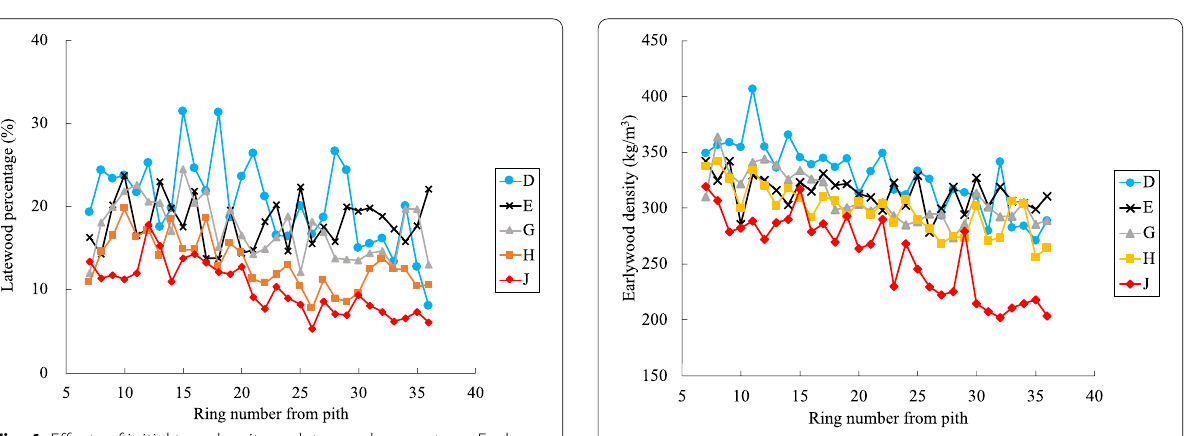
Fig. 4 Effects of initial tree density on latewood percentage. Each plot shows an average value in a ring number among sample trees of each tree density zoning symbol. Number of sample trees of each initial tree density zoning symbol range from five to nine. Initial tree density zoning symbols were the same, as shown in Table 1.